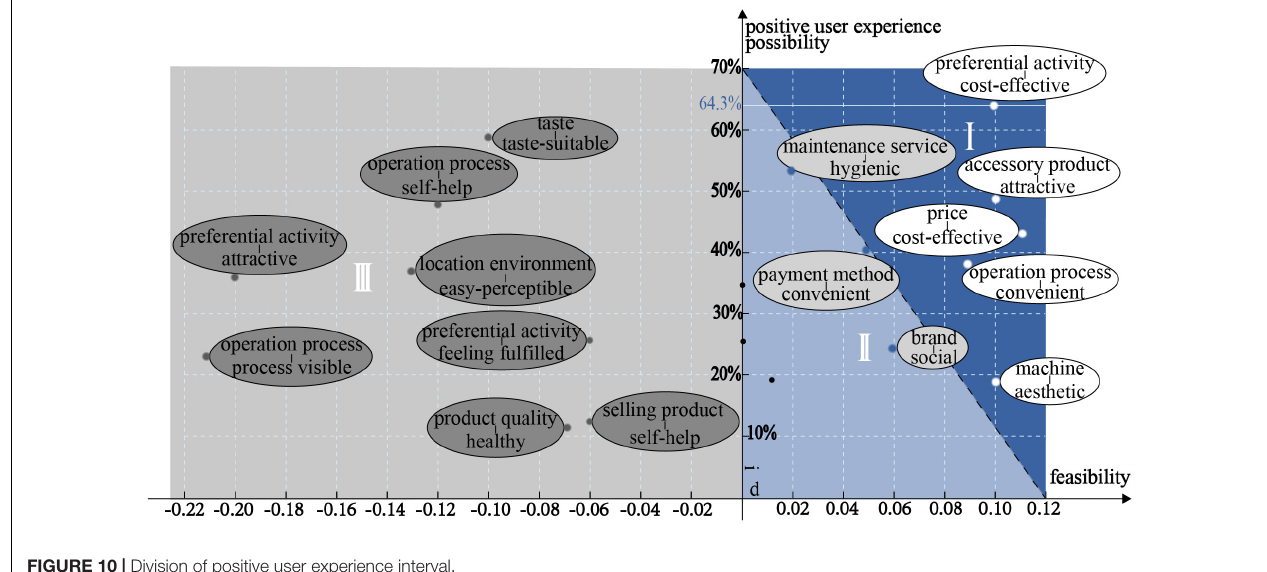
FIGURE 10 | Division of positive user experience interval.